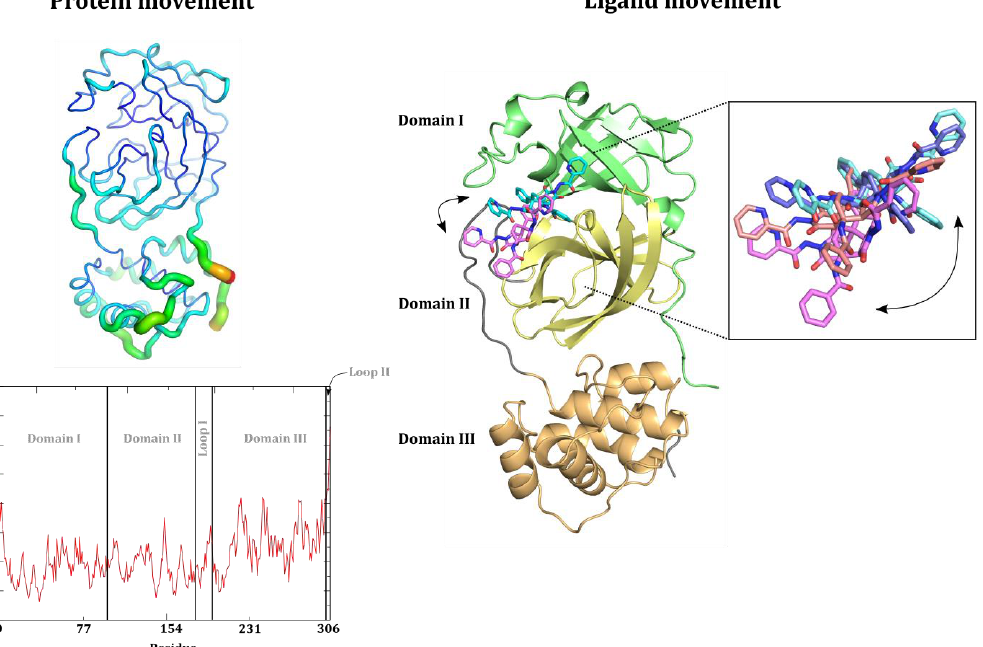
Figure 4. SARS-CoV-2 3CL pro protease (PDB:6LU7) and fused bicyclo[2.2.2]octene 11a movements observed during the molecular simulation: (right) RMSF heatmap, visualization of the calculated RMSF values, and a corresponding RMSF graph of the protein residues. Both pinpoint the flexibility of the domain III. (left) Detected movement/positions of ligand 11a in the SARS-CoV-2 3CL pro active site.